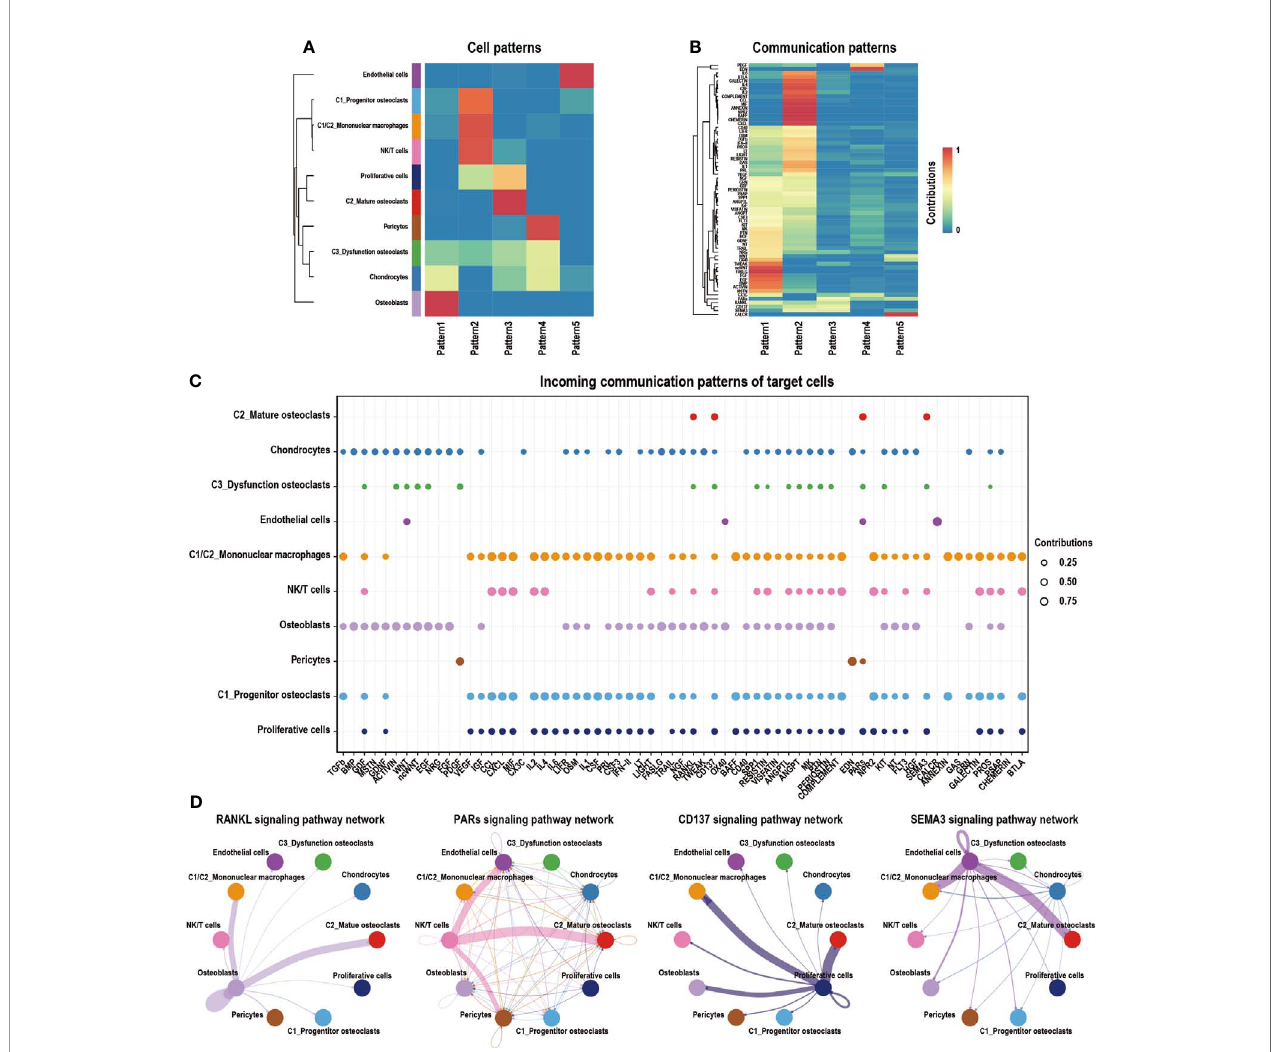
FIGURE 7 | Cell – cell communication network of CellChat in GCTB. (A) Heatmap showing the enrichment of different cell types in different modules. The deeper red the color is, the higher its degree of enrichment. (B) Heatmap showing the contribution of different signaling pathways in different expression modules. The deeper the red color is, the higher the contribution of the signaling pathways. (C) A bubble plot showing the signaling pathways of interest in GCTB as detected by CellChat. (D) An interaction network shows the ligand – receptor pairs that have a known biological signi fi cance. GCTB, giant cell tumor of